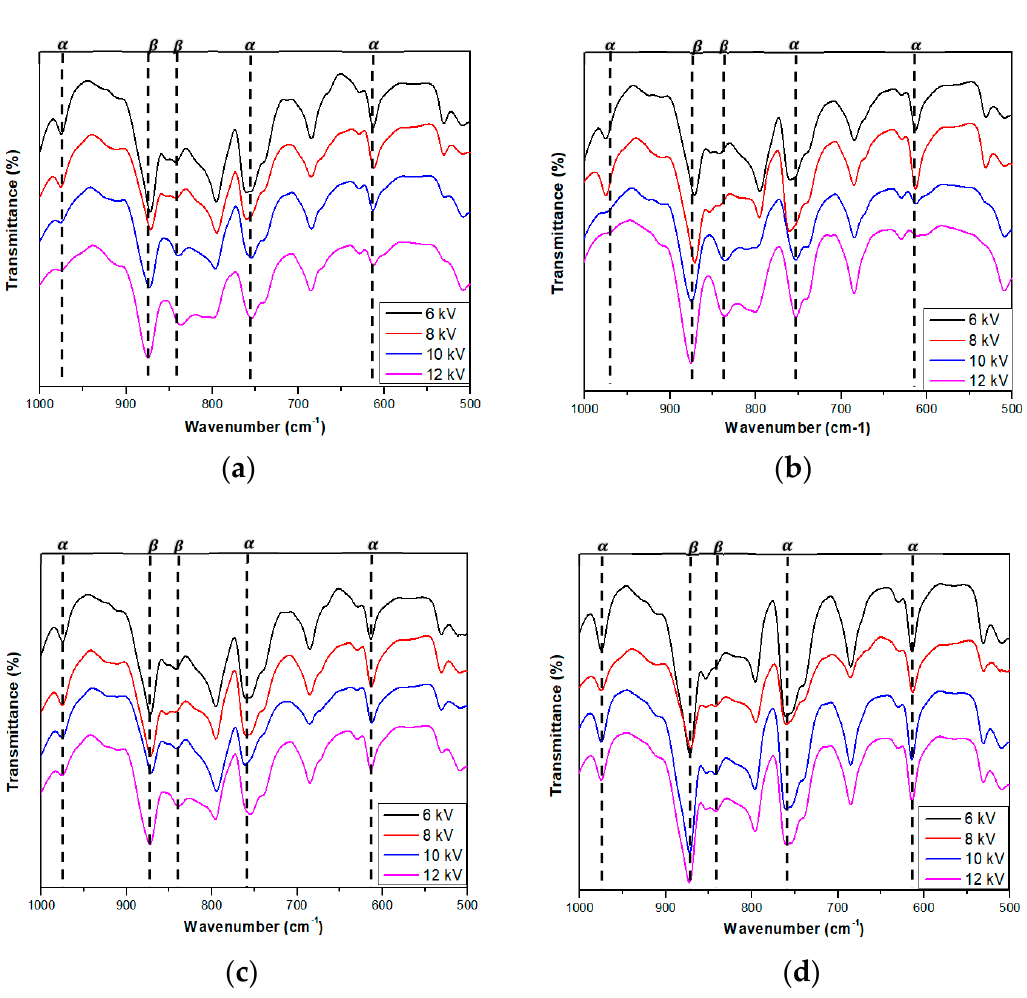
Figure 8. FT-IR spectra of the poled PVDF/PAR composites at drawing temperatures of ( a ) 70, ( b ) 90, ( c ) 110, and ( d ) 130 °C.